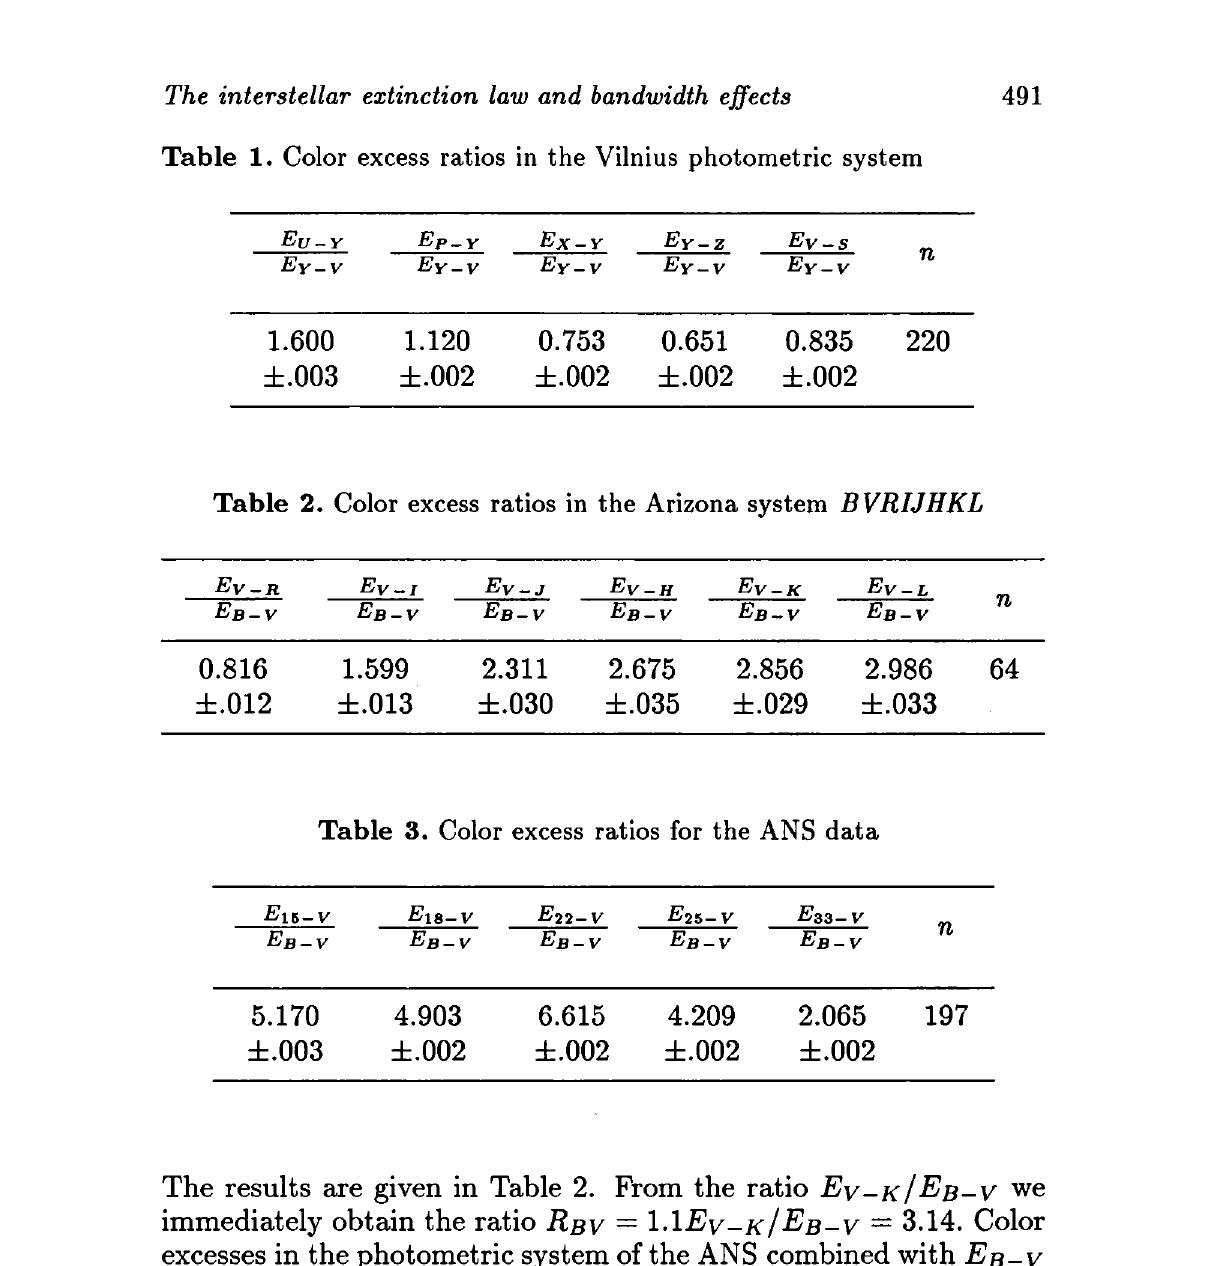
Table 1. Color excess ratios in the Vilnius photometric system